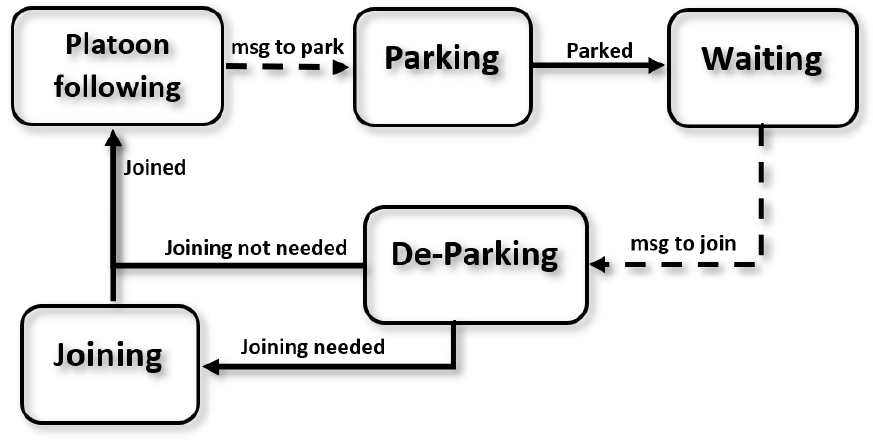
Figure 2. Finite state machine for the followers’ behavior. Communication-related jump conditions are represented with dashed